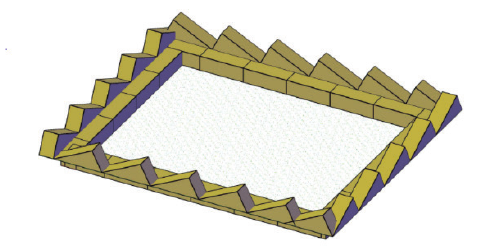
Figure 4. Golzar (source: authors)